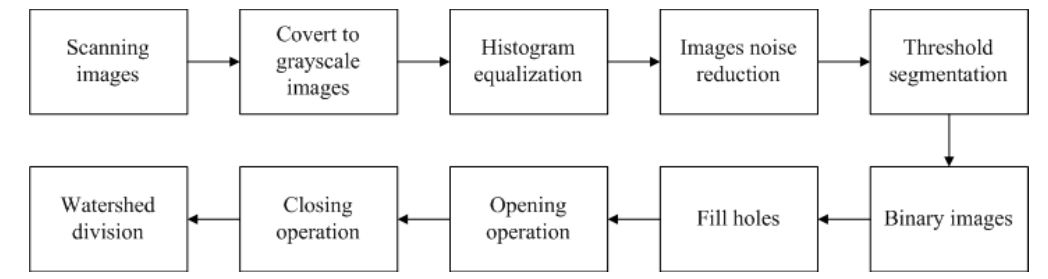
Figure 2. The operation flow of two-dimensional digital image processing.